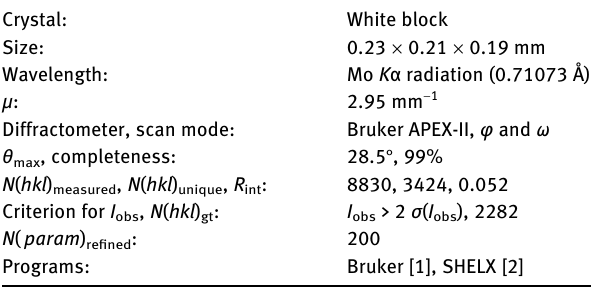
Table  : Data collection and